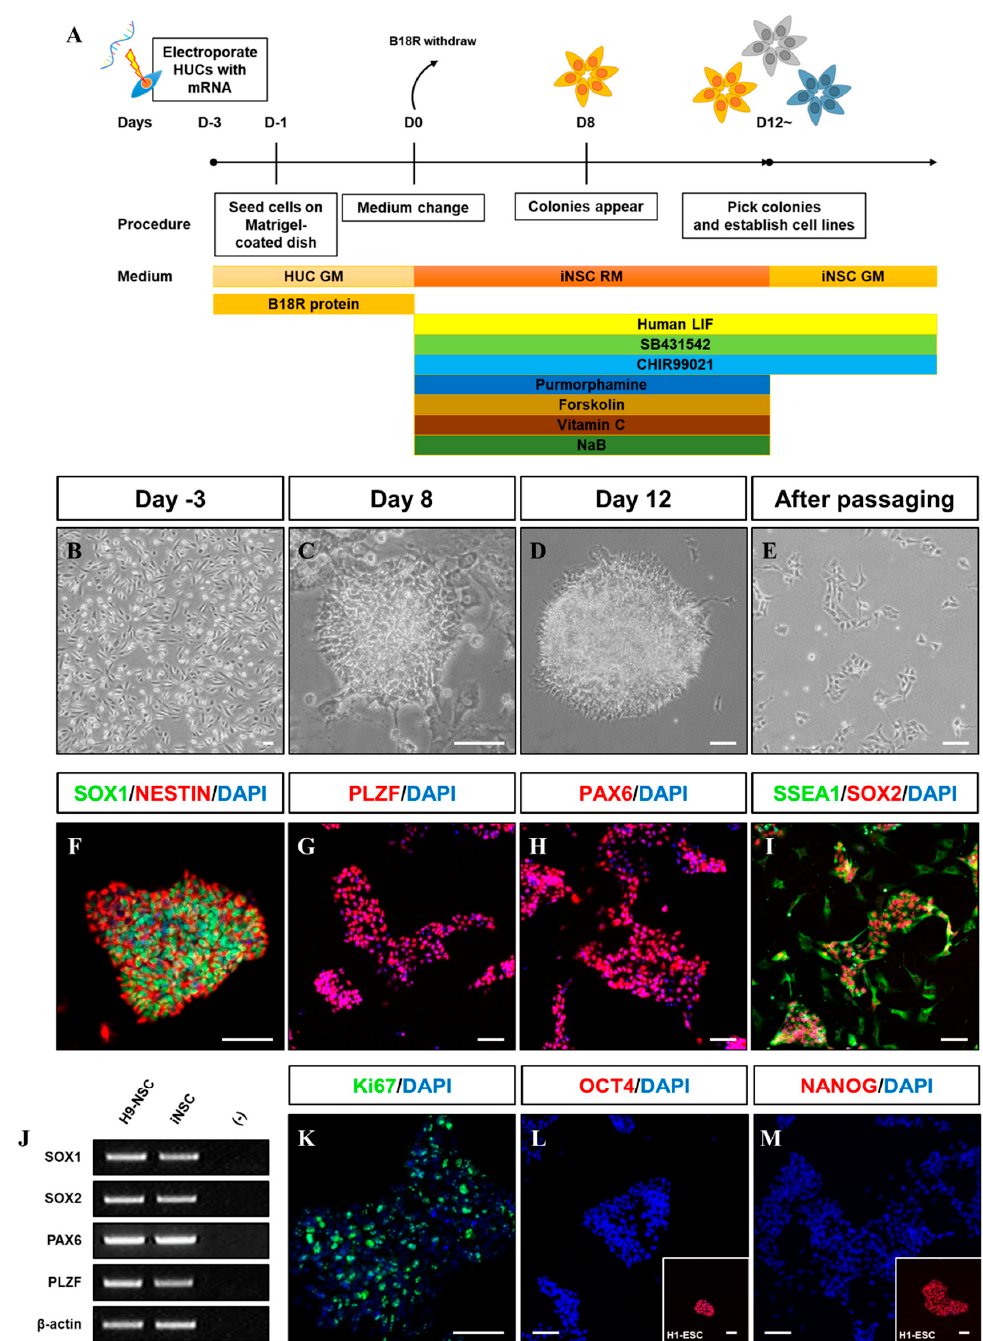
Figure 2. Generation of iNSCs from HUCs by self-replicating mRNAs with small molecules. ( A ) Schematic of the time course of the process used to directly convert HUCs into iNSCs. ( B ) Morphology of HUCs after transfection of self-replicating mRNAs. ( C , D ) Morphology of iNSC colonies exhibit neuroepithelial colony formation on day eight and 12. ( E ) Morphology of iNSCs after passaging using Accutase solution. ( F – I ) NSC markers (SOX1, NESTIN, PLZF, PAX6, SSEA1, and SOX2) expression in iNSC colonies, as determined by immunofluorescence analysis. ( J ) NSC markers are expressed in iNSCs similar with H9-NSCs, as demonstrated by RT-PCR. ( K ) Ki67 staining in iNSCs, as determined by immunofluorescence analysis. ( L , M ) OCT4 and NANOG expression in iNSCs and H9-ESCs, as determined by immunofluorescence analysis. Scale bars, 200 μ m.